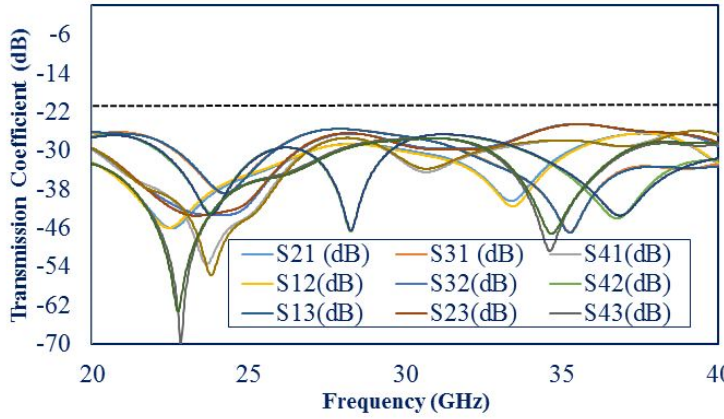
Figure 10. Simulated transmission coefficient results for four-port MIMO antenna.